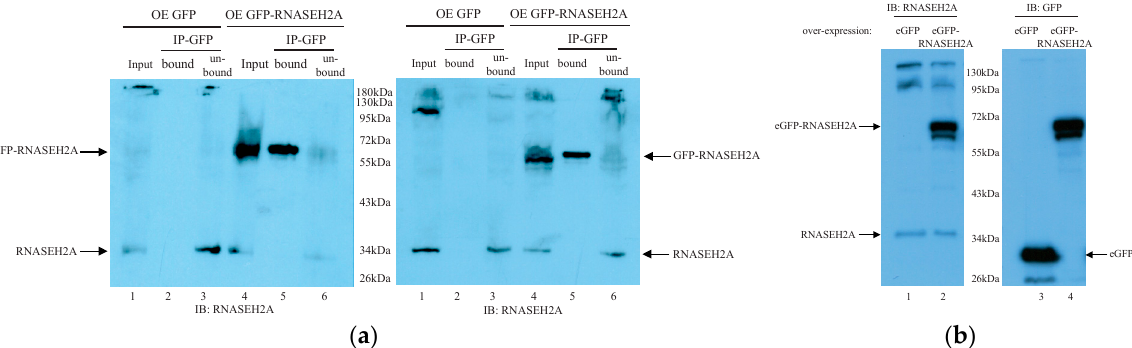
Figure 4. Co-immunoprecipitation and antibodies verification: ( a ) co-immunoprecipitation of RNASEH2A. Western Blot of the GFP co-immunoprecipitation. The two panels indicate two independent experiments. HEK293 cells were overexpressed (OE) with the eGFP vector (lanes 1–3 in each panel) or with the eGFP-RNASEH2A vector (lanes 4–6 in each panel). IP: anti-GFP, IB: anti-RNASEH2A. Arrows indicate endogenous RNASEH2A (lower arrow) and exogenous eGFP-RNASEH2A (upper row); ( b ) RNASEH2A and GFP antibodies verification. Western Blot of the anti-RNASEH2A (left panel) and the anti-GFP (right panel). In the two panels, HEK293 cells were OE with eGFP vector (lanes 1, 3) or eGFP-RNASEH2A vector (lanes 2, 4). In the left panel, arrows indicate endogenous RNASEH2A (lower arrow) and exogenous eGFP-RNASEH2A (upper row). In the right panel, arrows indicate eGFP (lower arrow) and eGFP-RNASEH2A (upper row). Table 4. List of proteins identified as binding partners of RNASEH2A by mass spectrometry anal-